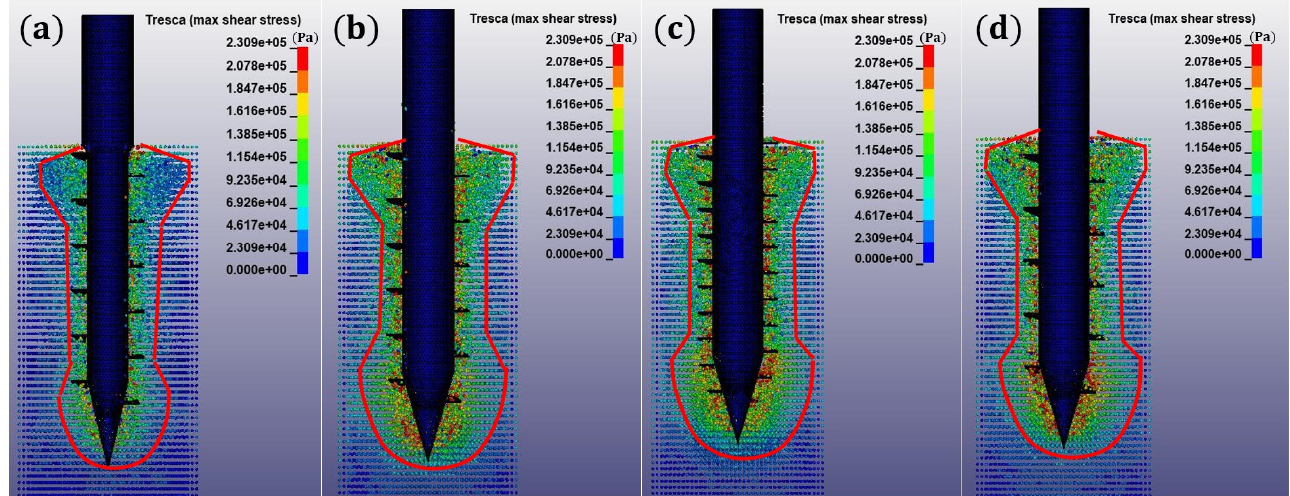
Figure 19. Soil stress contour caused by the installation of the screw pile: ( a ) NT2, ( b ) NT3, ( c ) NT4 and ( d ) NT5.